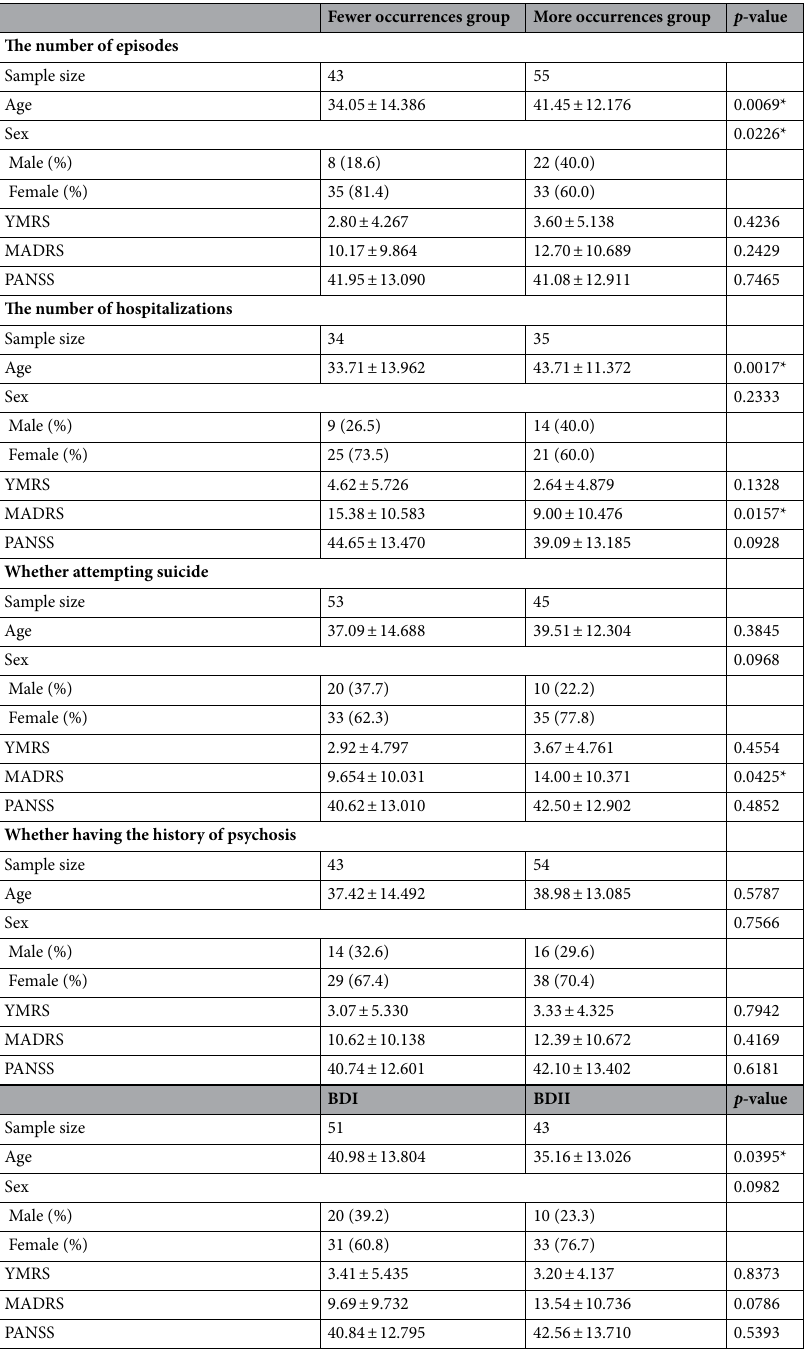
Table 1. Demographic data of groups with fewer and more occurrences of clinical patterns and diagnostic subtypes. * p < 0.05. YMRS Young Mania Rating Scale, MADRS Montgomery–Åsberg Depression Rating Scale, PANSS Positive and Negative Syndrome Scale, UKU UKU Side Effects Rating Scale, PSP Personal and Social Performance Scale, GAF Global Assessment of Functioning, BDI bipolar type 1 disorder, BDII bipolar type 2